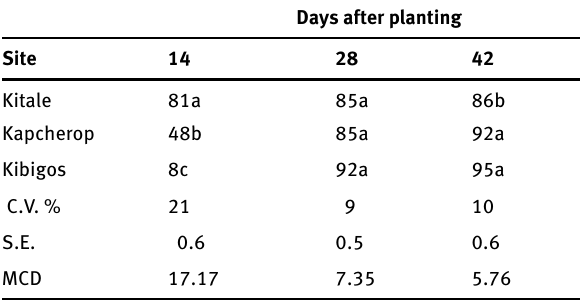
Table 1: Influence of site on seed potato emergence (%) Days after